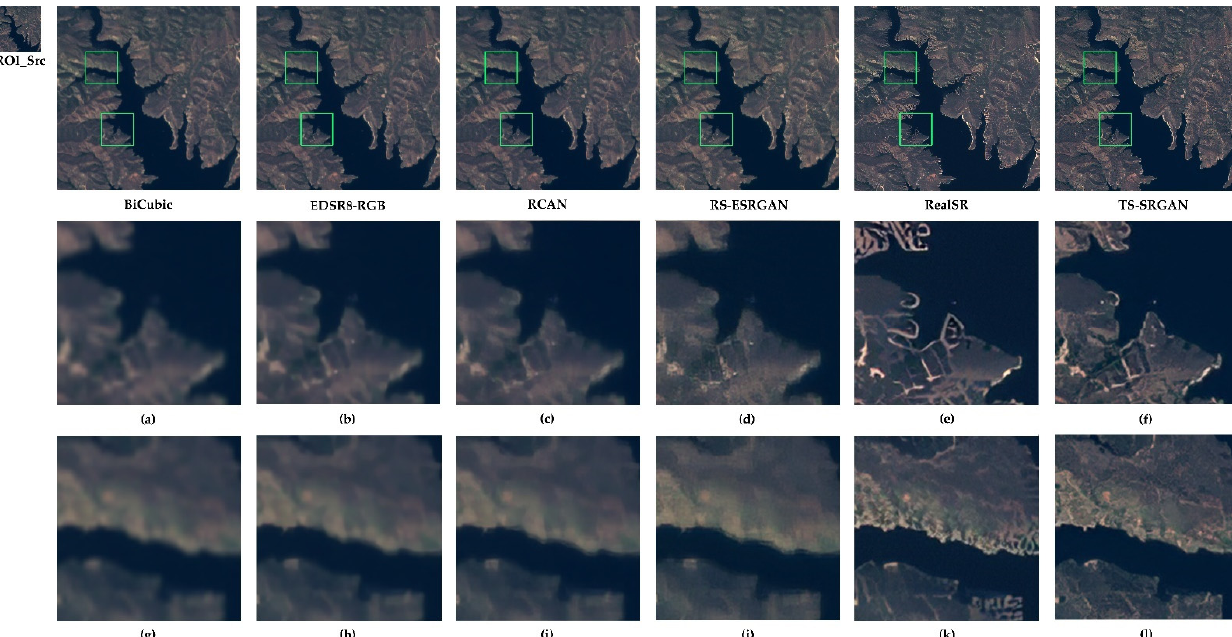
Figure 15. Comparison of visual effects of the generated images of the region with hilly terrain. NR- IQA of images (NIQE, BRISQUE, PIQE): BiCubic (6.35, 58.38, 92.36), EDSR8-RGB (5.88, 48.02, 81.31), RCAN (4.62, 46.94, 52.83), RS-ESRGAN (3.99, 27.62, 7.61), RealSR (2.83, 13.25, 7.84), TS-SRGAN (2.74, 3.83, 15.57). The subfigures ( a – l ) in the figure represent an enlarged view of the local details in the green boxes in the generated image.